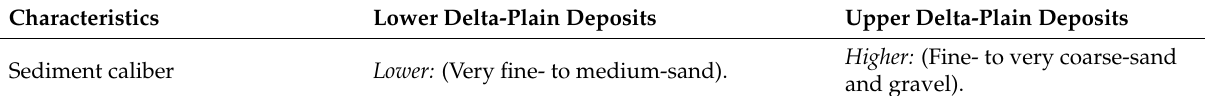
Table 2. Comparable table that portrays the main differences between the studied Upper Permian lower and the upper delta-plain